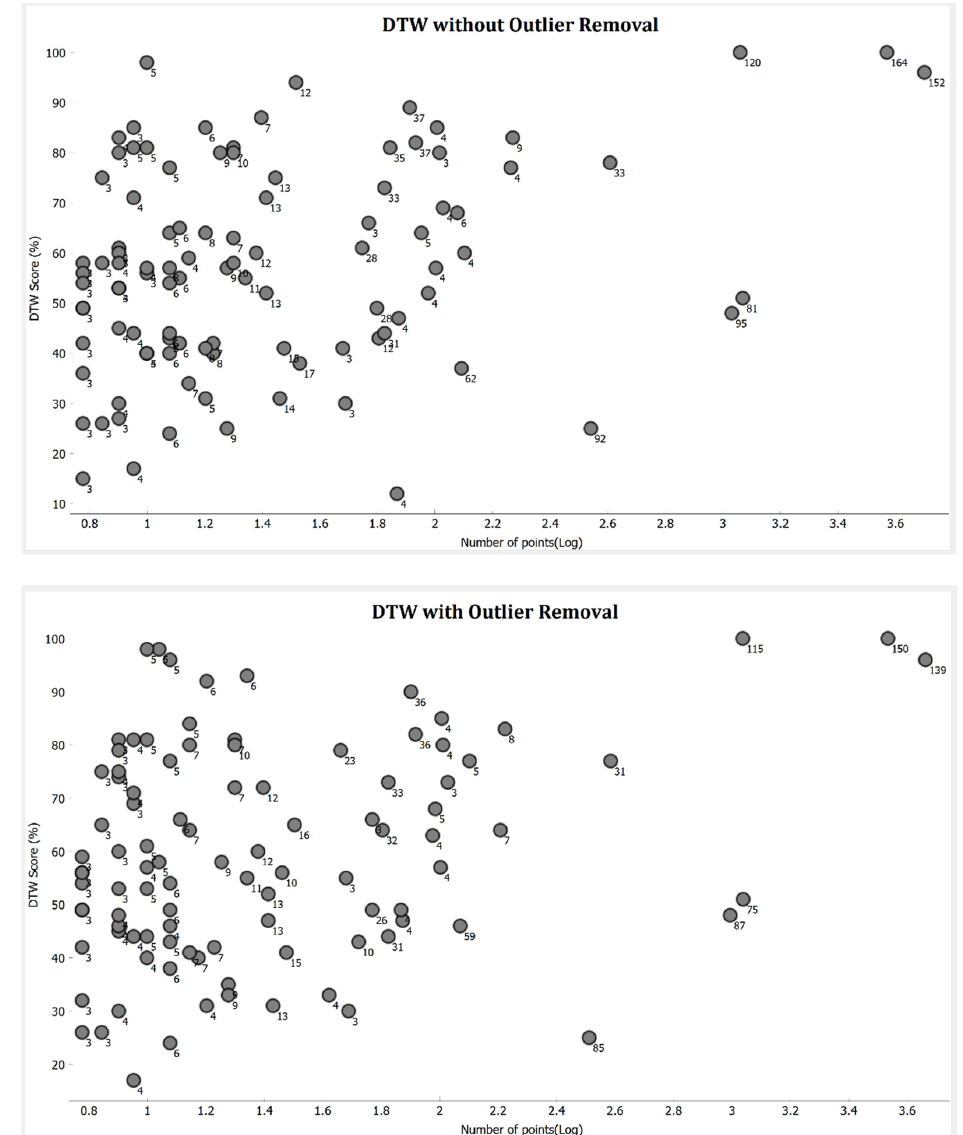
Figure 14. Result of 100 datasets plotted as a function of the points (log scale) in the set. Results are for DTW before outlier removal ( above ) and DTW after outlier removal ( below ). Each dot represents one set and the number shows how many trajectories are in the set.